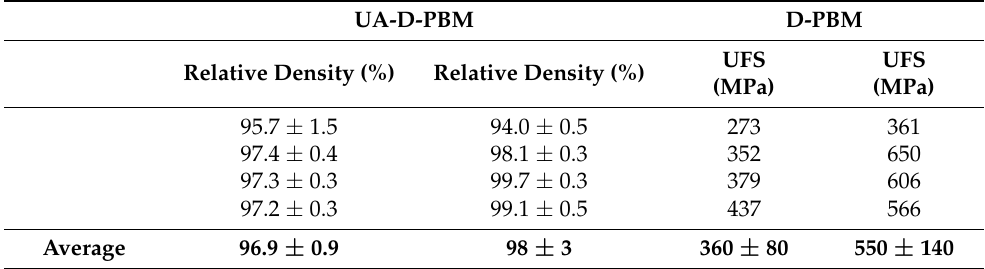
Table 4. Density and ultimate flexure strength (UFS) of the composites from powder processed by ultrasonic agitation followed by dry planetary ball milling (UA-D-PBM) and dry planetary ball milling